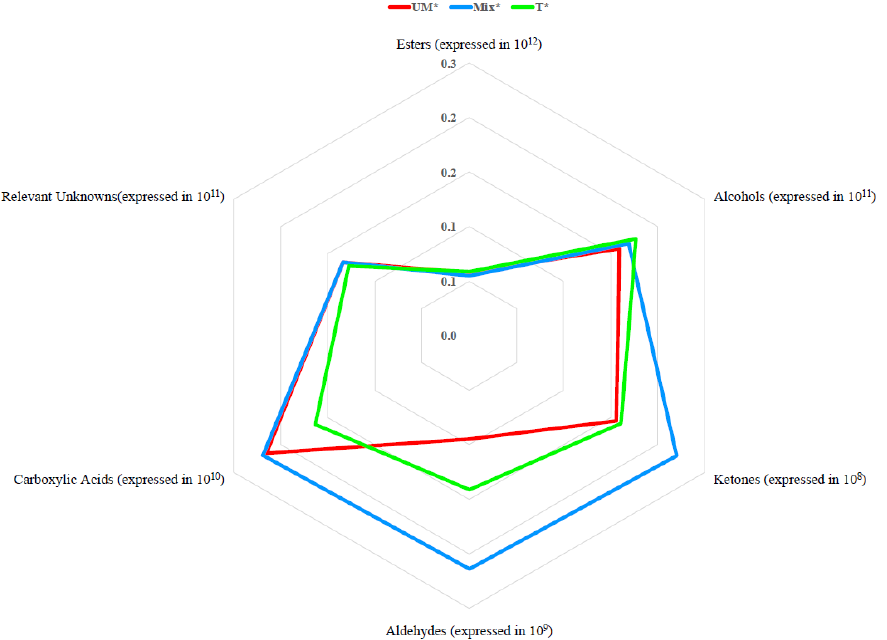
Figure 3. Spider graph of the volatile compounds for all Antão Vaz white wines (UM*, Mix*, and T*), distributed according to their flavour